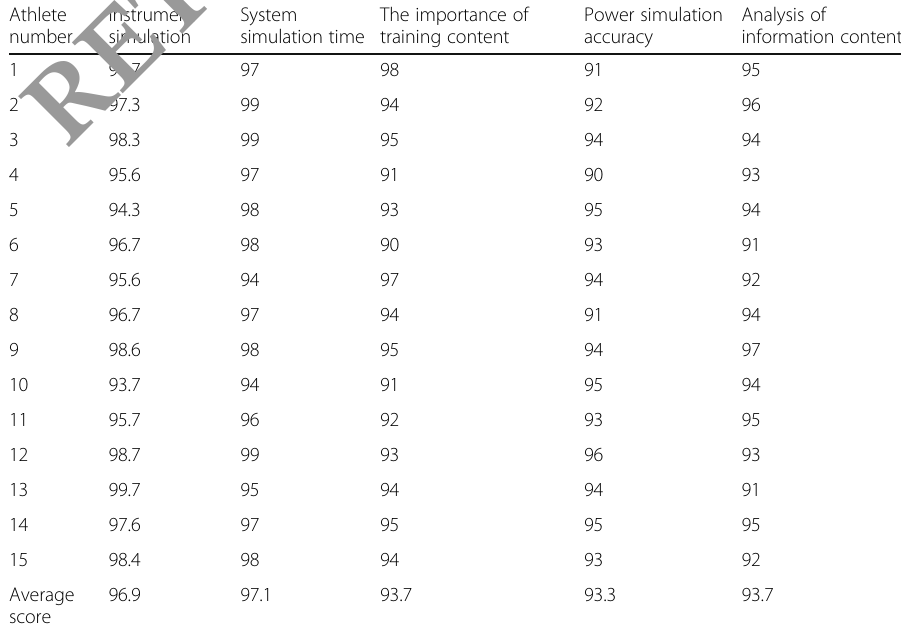
Table 4 Evaluation score of the proposed system analysis results (points) Athlete Instrument number